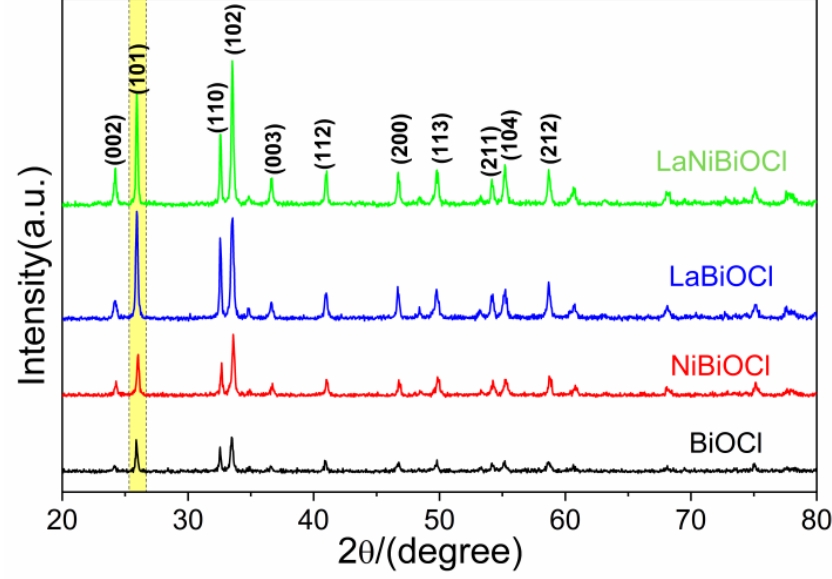
Figure 1. XRD patterns of as-prepared samples.